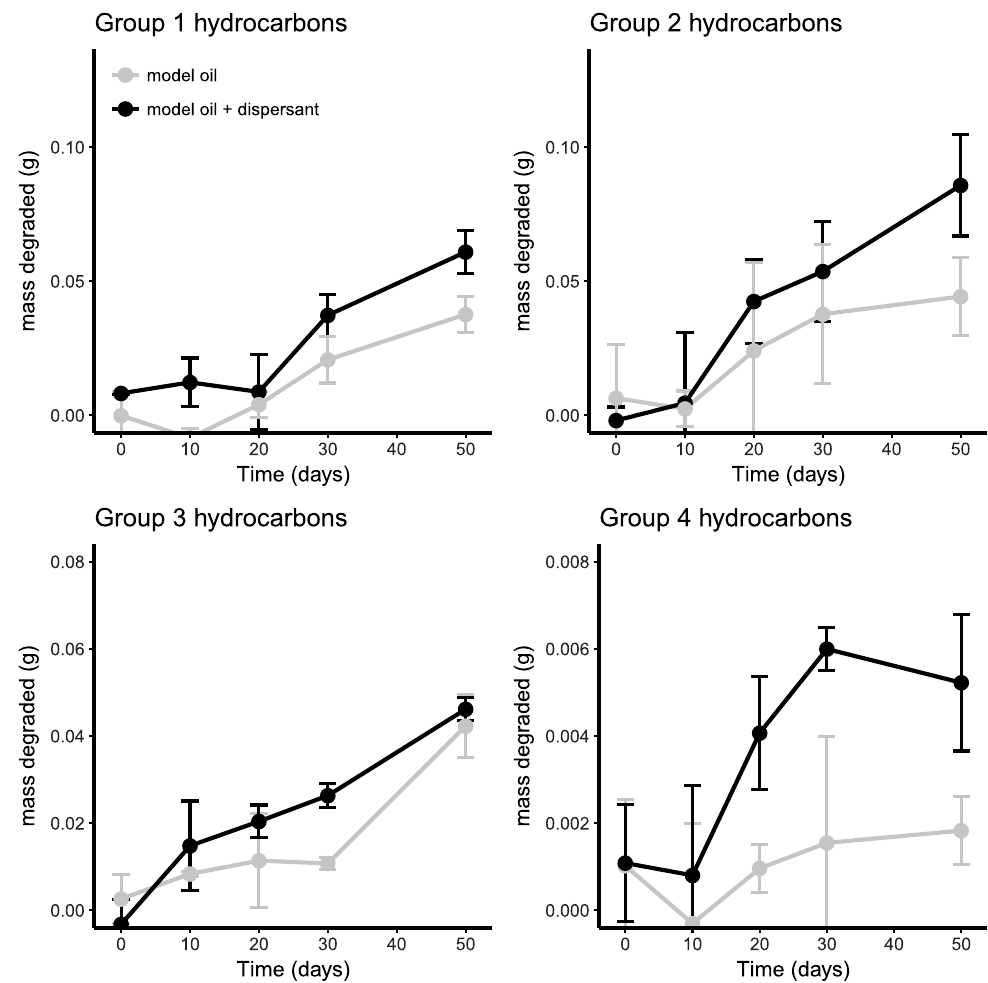
Figure 2. Mass of each aliphatic hydrocarbon group degraded during slurry incubations in FSC1000 at 0 °C. Error bars are standard deviation, n = 3. Black lines are model oil and grey are model oil +